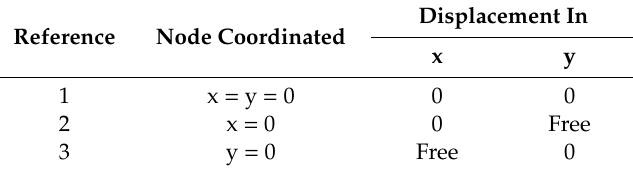
Table 3. Boundary conditions for the in-plane stress finite element model.